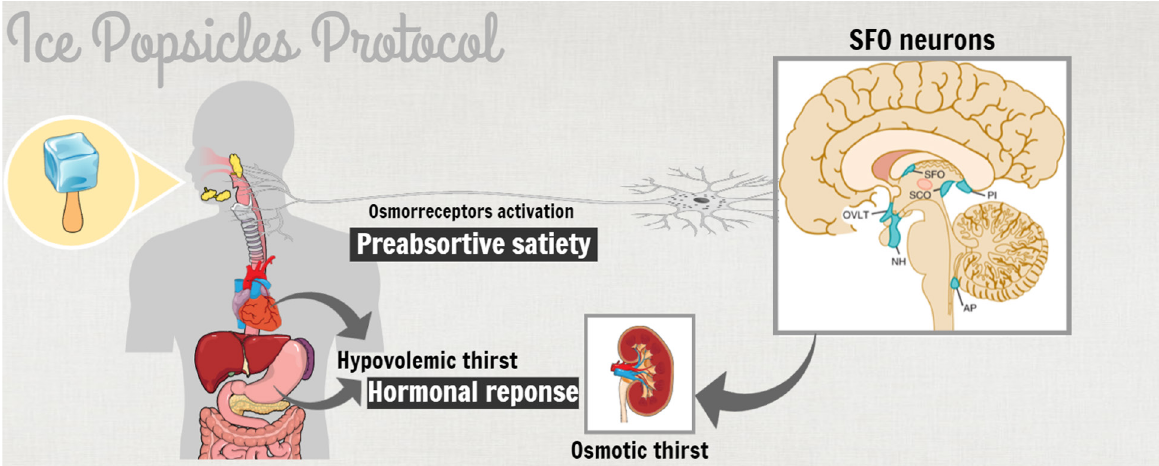
Figure 8. Schematic diagram illustrating the thirst management mechanism in postoperative patients treated with ice popsicles. The thirst relief consists of two different processes, preabsortive and hormonal response. The first is characterized by the oropharyngeal stimulation from cold and could generate thirst satiety before water consumption and changes promoted in the composition of blood. This mechanism activates the consciousness region represented by the posterior cingulate cortex, directly affected by regional cerebral blood flow, and develops an inhibition of vasopressin release. Secondly, the hormonal response is divided into two different conditions: osmotic and hypovolemic. These mechanisms occur when dehydration promotes changes in intracellular and extracellular volume. In these cases, osmotic thirst initiates with the dehydration of supraoptic neuronal cells promoted by plasma hyperosmolarity, it stimulates the secretion of the vasopressin hormone. However, hypovolemic thirst is activated with a decrease in blood volume and promotes the secretion of angiotensin II and consequently, sodium retains. All these mechanisms were activated in distinct circumstances, stimulating organs like the brain and kidneys to respond and promote the thirst relief. SFO: subfornical organ neurons. Figure created using the Mind the Graph